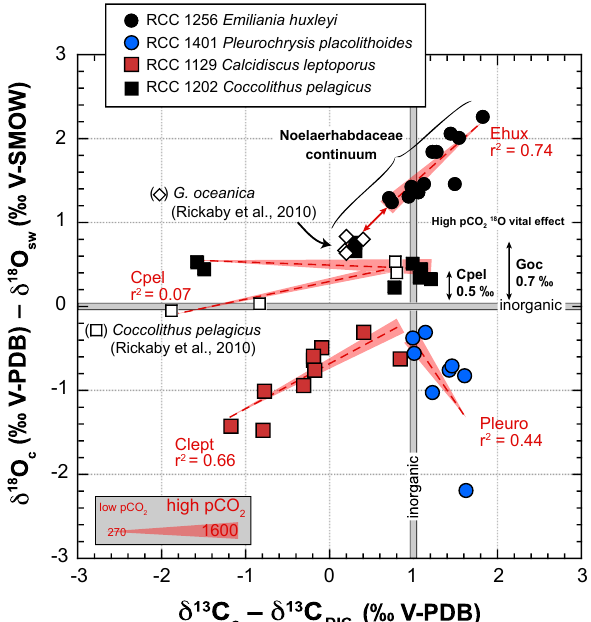
Figure 3. Scatter plot of carbon and oxygen isotopic offsets with increased DIC concentration. Superimposed on the linear regres- sion lines, the wider side of the red triangles denotes a higher DIC level. With increased DIC and aqueous CO 2 concentration in the medium, we observe a clear decrease in the magnitude of isotopic disequilibria in both carbon and oxygen systems, with coccolith iso- tope compositions converging towards inorganic composition. Note that a correction of + 0.64‰ was applied to the δ 18 O c values of Rickaby et al. (2010) to account for a temperature offset of + 3 ◦ C with the culture data of the present